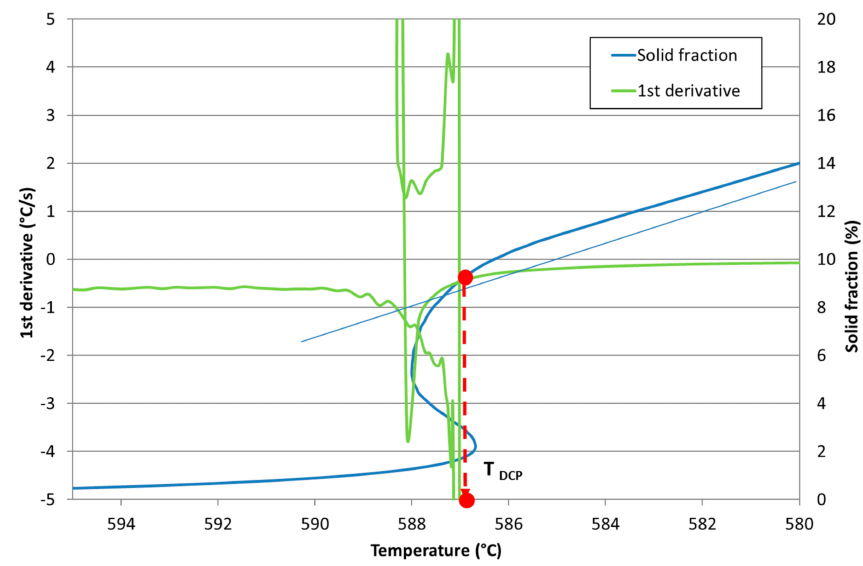
Figure 4. Method 4: dfs/dT curve vs. T, with the DCP point in the elbow.